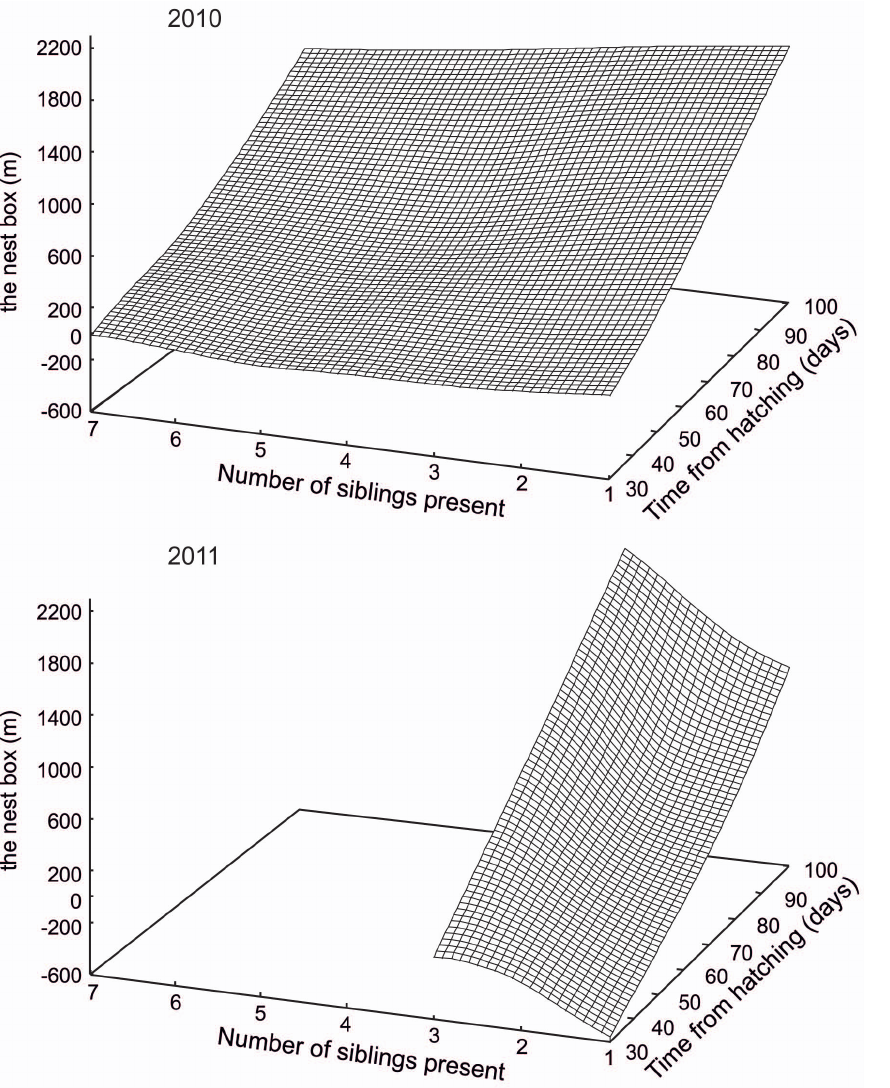
Figure 3. Predicted values of the distance from the nest box for 2010 (top) and 2011 (bottom) plotted against the number of siblings present and the time from hatching.